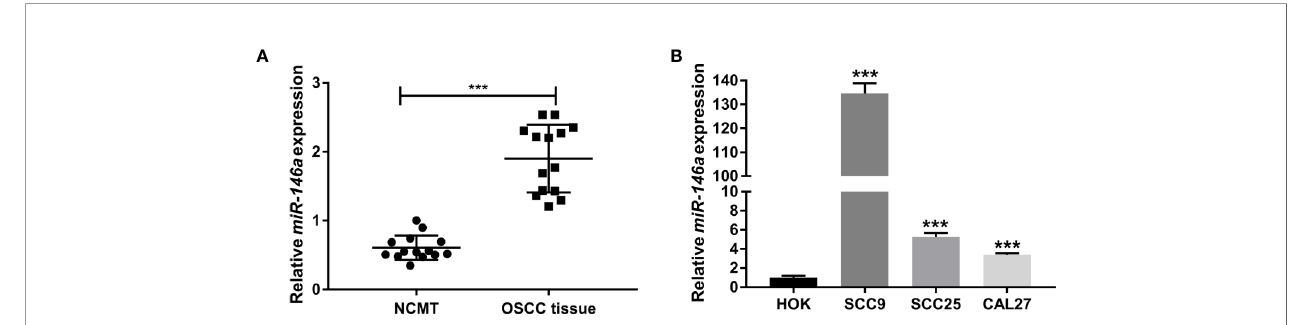
FIGURE 1 | MiR-146a expression was upregulated in OSCC tissues and OSCC cell lines. (A) MiR-146a expression pattern in OSCC tissues and non-cancerous matched tissues (n = 14). (B) MiR-146a expression pattern in HOK cells and OSCC cell lines (n = 3). Data are presented as mean ± SD. The signi fi cant difference, ***P < 0.001 [in (B) compared to HOK-group]. NCMT, non-cancerous matched tissue; OSCC, oral squamous cell